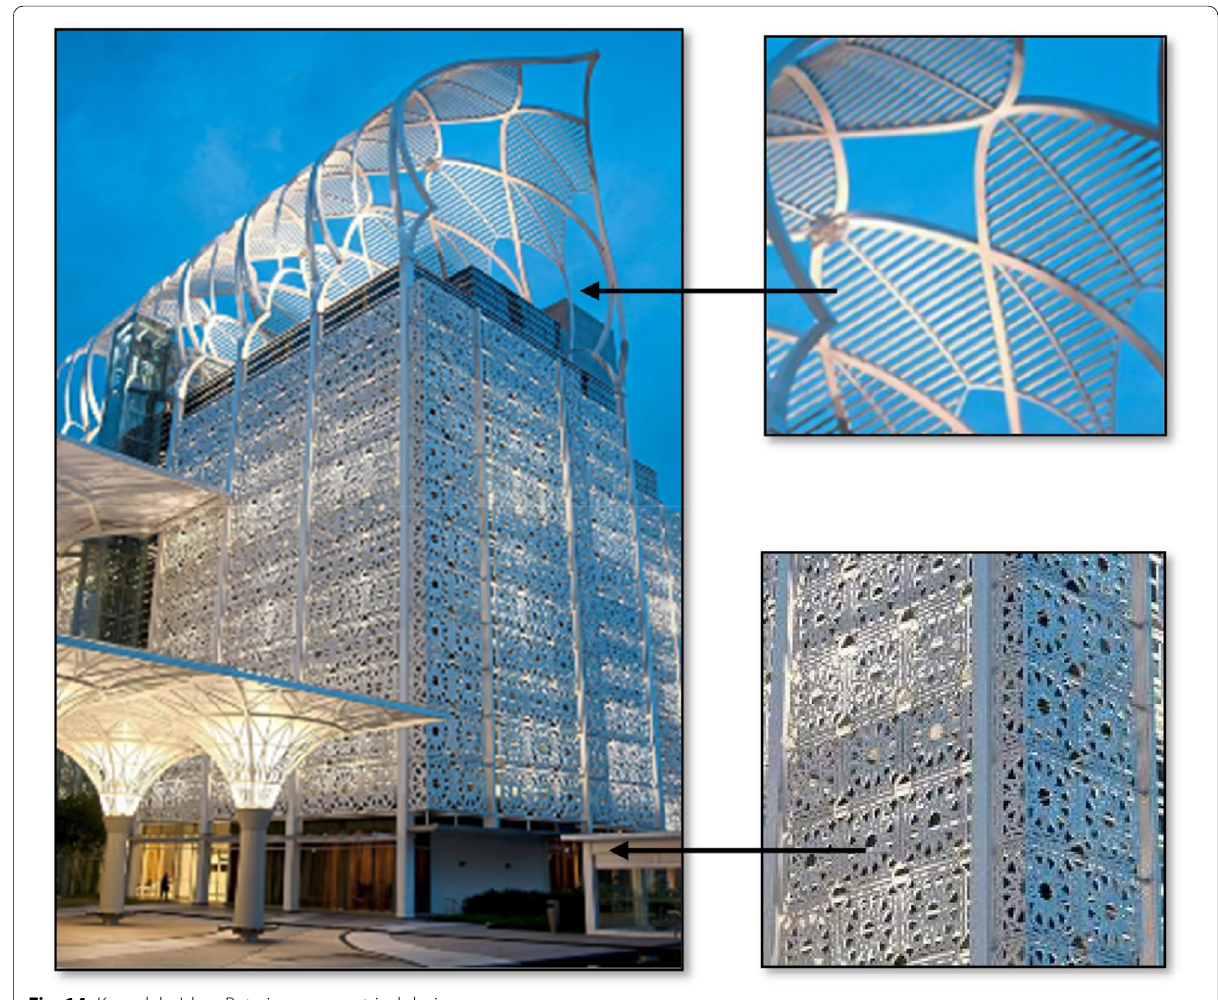
Fig. 14 Kompleks Islam Putrajaya, geometrical design